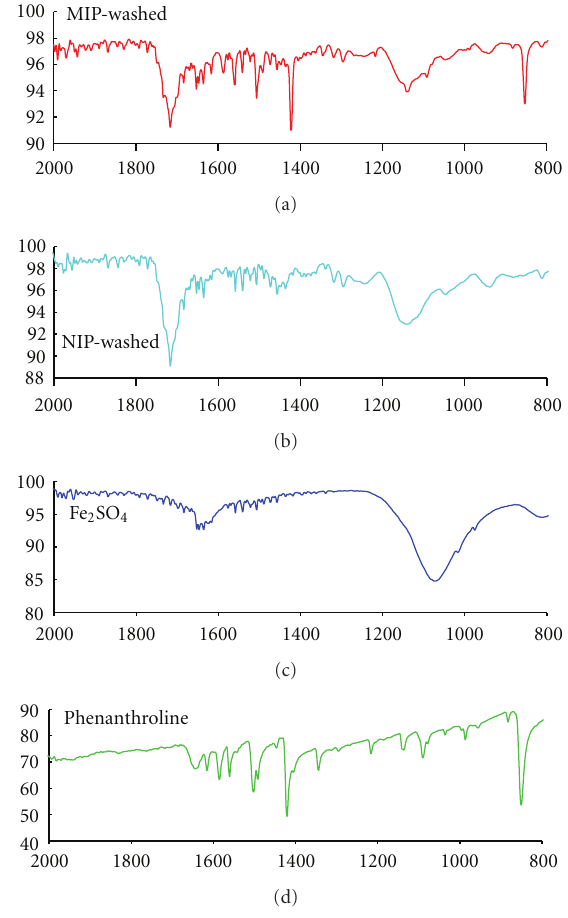
Figure 1: FTIR spectra of IIP (a), NIP (b), FeSO4, and 1,10- phenanthroline (d). (Scan from 2000 to 800 cm − 1 , with background correction, and room temperature/humidity